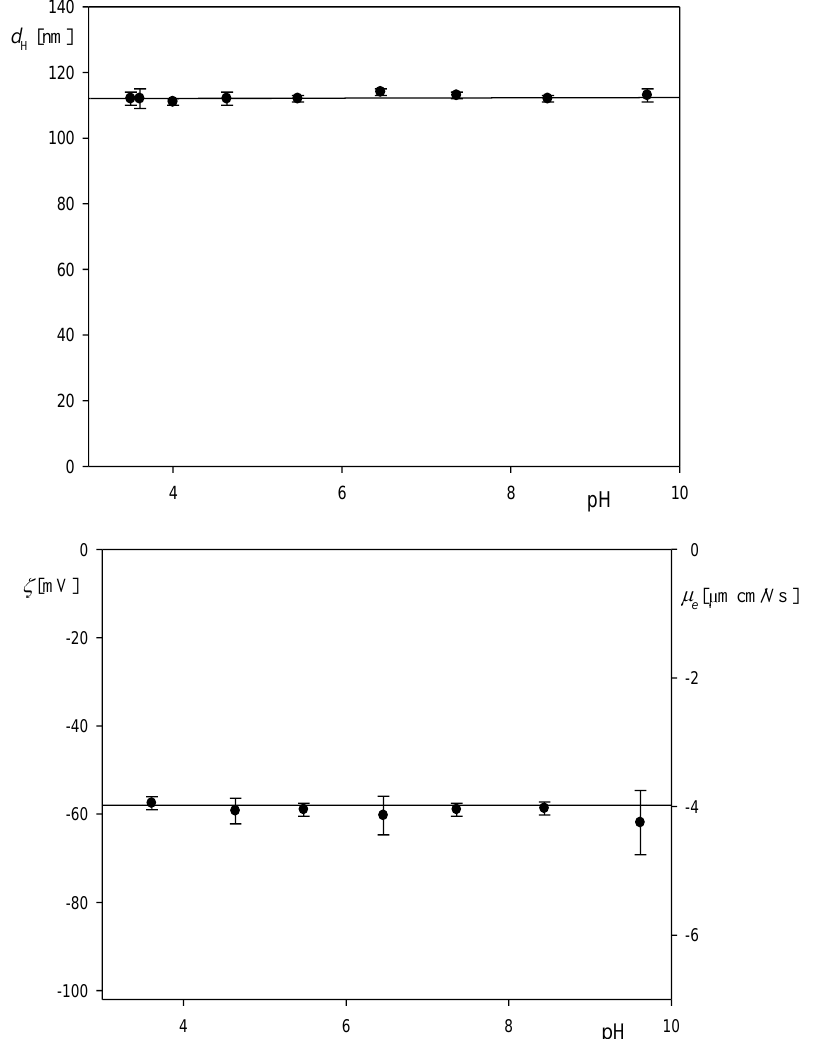
Figure 3. ( a ) Dependence of the hydrodynamic diameter of the polystyrene particles on pH: (●) 10 mM NaCl. The dashed line shows the average value of the hydrodynamic diameter equal to 115 ± 5 nm. ( b ) Dependence of the zeta potential of the particles on pH (left-hand axis) and the electrophoretic mobility (right-hand axis): (●) 10 mM NaCl. The solid line shows the average value of the zeta potential equal to − 55 ± 5 mV.